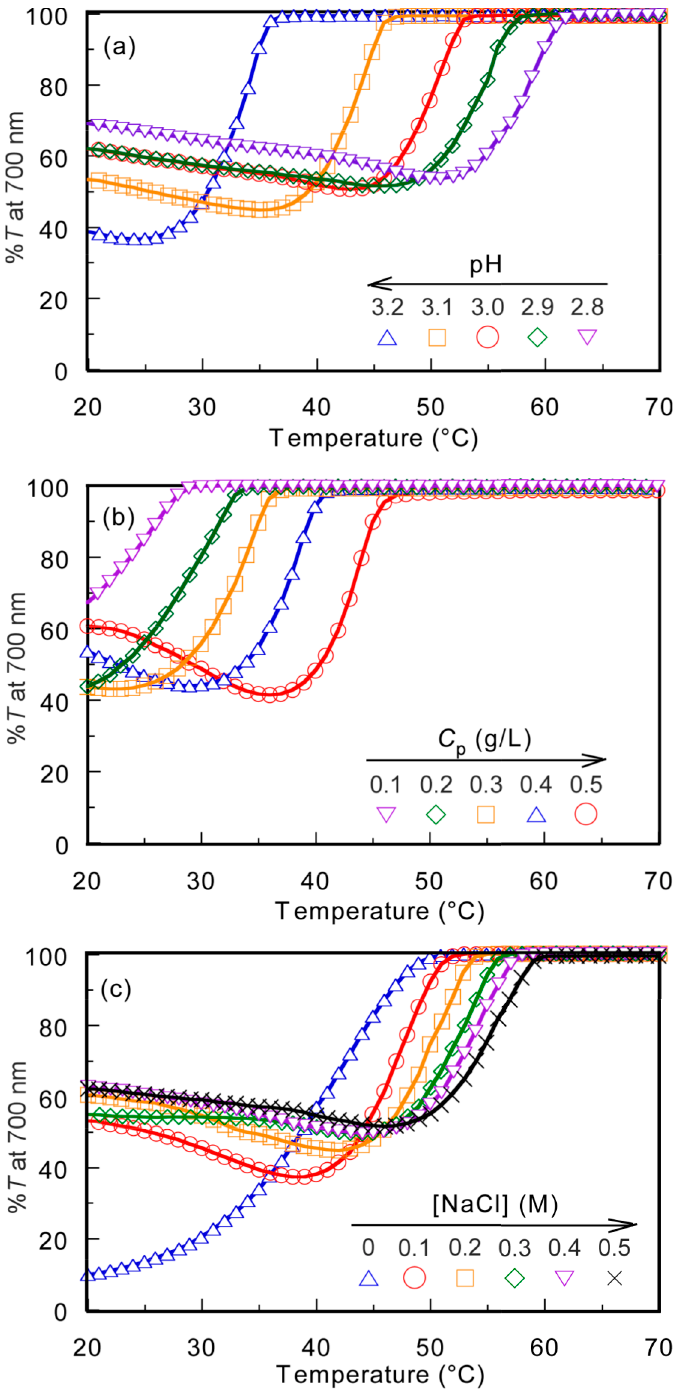
Figure 4. Percent transmittance (% T ) at 700 nm for PMPC/PAAc mixed aqueous solutions with f AAc = 0.85 as a function of temperature at pH 3, C p = 0.5 g/L, and [NaCl] = 0.1 M, which is a standard condition: ( a ) pH, ( b ) C p , and ( c ) [NaCl] dependence on the phase transition behavior.